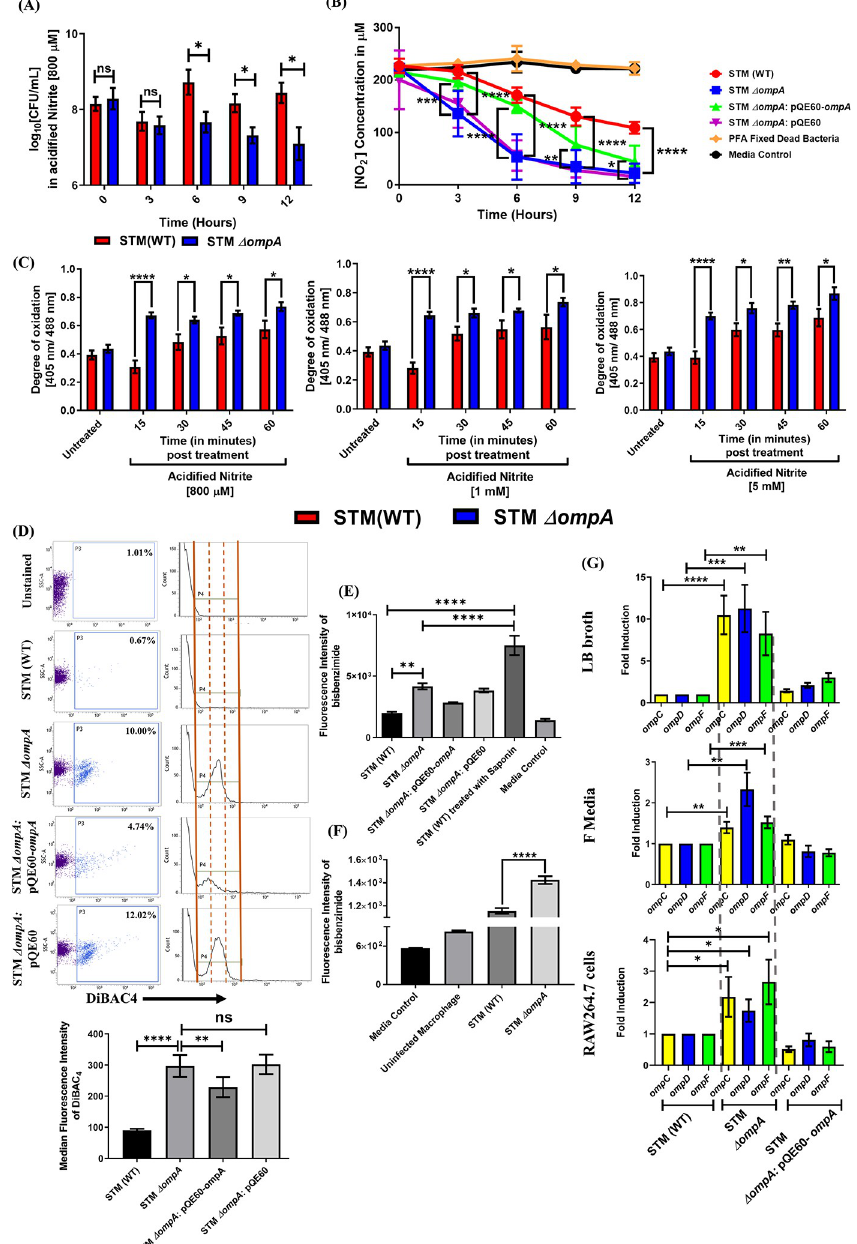
Fig 5. OmpA-dependent regulation of outer membrane permeability in Salmonella controls cytoplasmic redox homeostasis in response to in vitro nitrosative stress. (A) Time-dependent in vitro death kinetics of STM (WT) and Δ ompA in the presence of acidified nitrite (Nitrite concentration 800 μ M in PBS of pH 5.4). Data are represented as mean ± SEM (N = 5). (B) In vitro nitrite uptake assay of STM (WT), Δ ompA , Δ ompA : pQE60- ompA , Δ ompA : pQE60, & PFA fixed dead bacteria (n = 3, N = 4). (C) Time-dependent measurement of redox homeostasis of STM (WT) and Δ ompA harboring pQE60-Grx1-roGFP2 in response to varying concentrations of acidified nitrite. Median fluorescence intensities of Grx1-roGFP2 at 405nm and 488nm for the FITC positive population were used to obtain the 405/ 488 ratio (n = 3, N = 3). (D) The dot plots (SSC-A vs. DiBAC 4 ) and histograms (Count vs. DiBAC 4 ) representing the outer membrane porosity of STM (WT), Δ ompA , Δ ompA : pQE60- ompA , & Δ ompA : pQE60 growing in acidic F media (12 hours post-inoculation). The median fluorescence intensity of DiBAC 4 (final concentration- 1 μ g/ mL) has been represented as a vertical bar graph (n = 3, N = 2). (E) Measurement of outer membrane porosity of STM (WT), Δ ompA , Δ ompA : pQE60- ompA & Δ ompA : pQE60 in acidic F media (12 hours post-inoculation) using bisbenzimide (excitation- 346 nm and emission- 460 nm), (final concentration- 1 μ g/ mL), (n = 8, N = 3). (F)